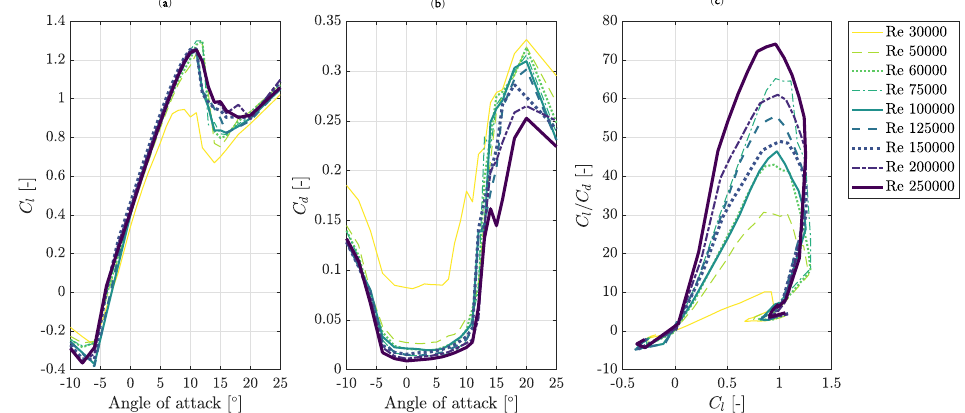
Figure 3. Aerodynamic coefficients of the SD7032 airfoil for several Reynolds numbers. ( a ) Lift coefficient. ( b ) Drag coefficient. ( c ) Lift-to-drag